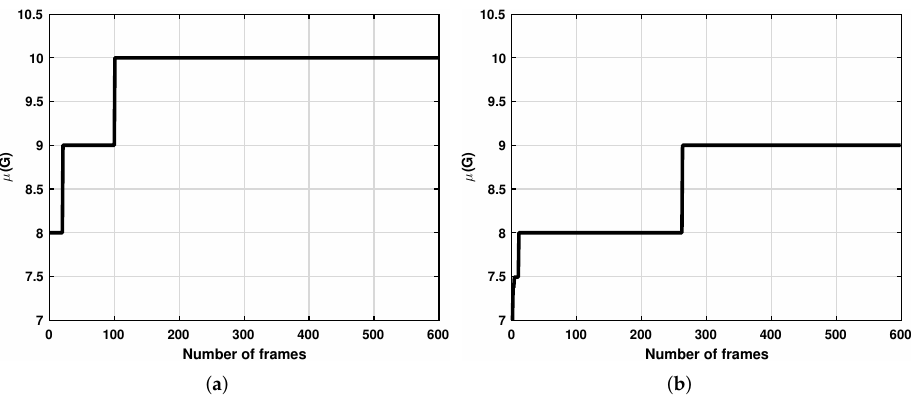
Figure 3. ( a ) µ ( G ) of the land clutter graph and ( b ) µ ( G ) of the sea clutter